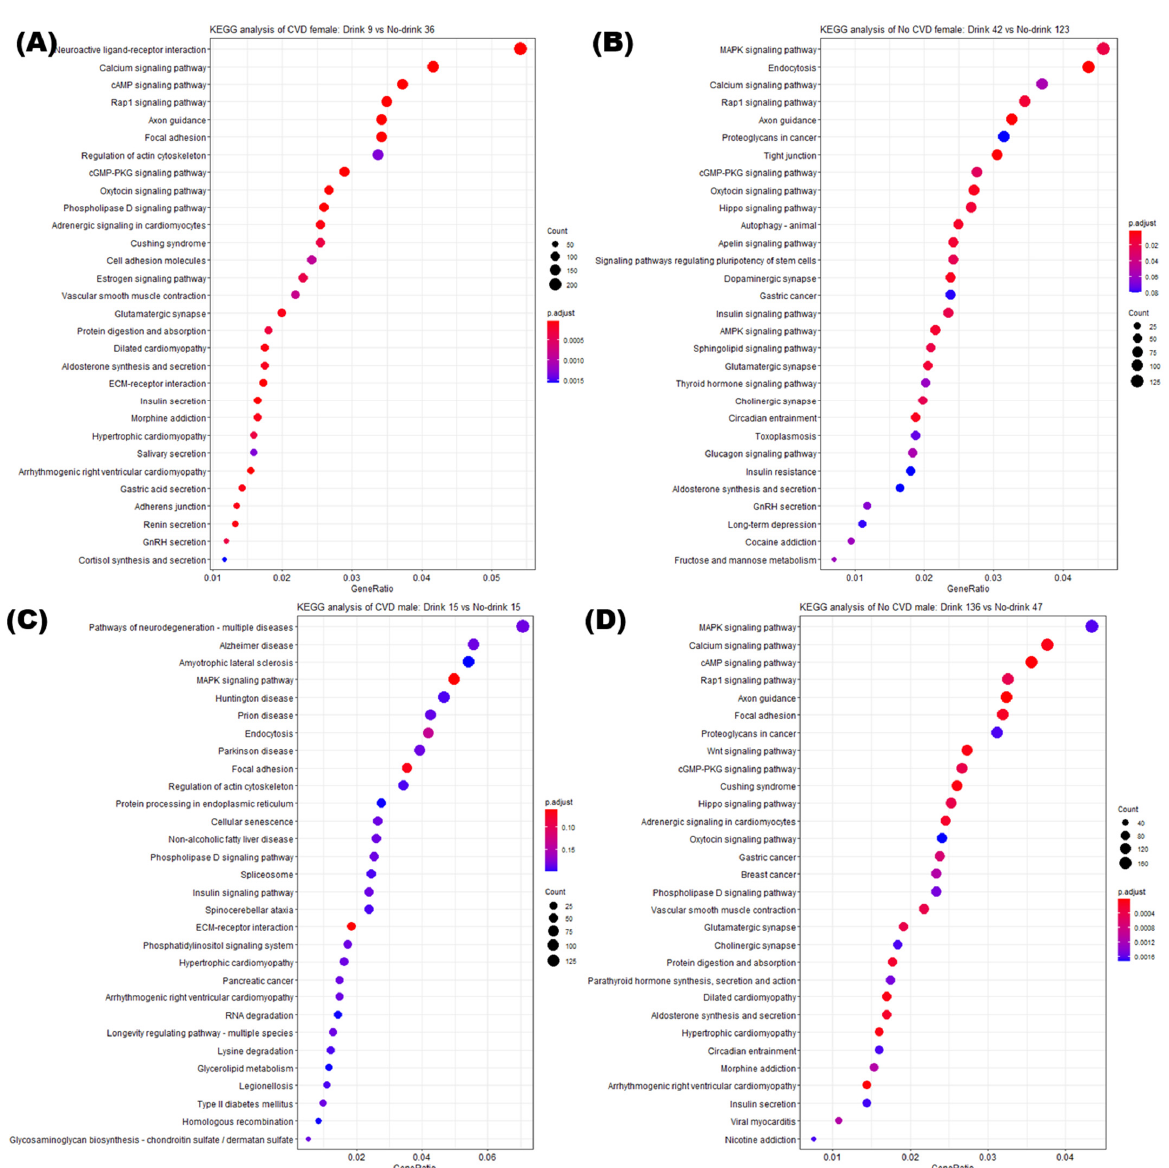
Figure 5. Enriched KEGG pathways of the DMRs indicating the difference between four pairs of the four groups. The top 30 enrichment KEGG pathways for DMRs satisfying the criteria p -value < 0.05 in each of the four pairs are presented. Color of the plot represents the p -value, and the size repre- sents the count of genes. ( A ) In females with chronic cardiovascular diseases (CVDs), the pairs of 9 drinkers versus 36 non-drinkers were compared. ( B ) In males with CVD, the pairs of 15 drinkers versus 15 non-drinkers were compared. ( C ) In females with non-CVD, the pairs of 42 drinkers ver- sus 123 non-drinkers were compared. ( D ) In females with CVD, the pairs of 136 drinkers versus 47 non-drinkers were